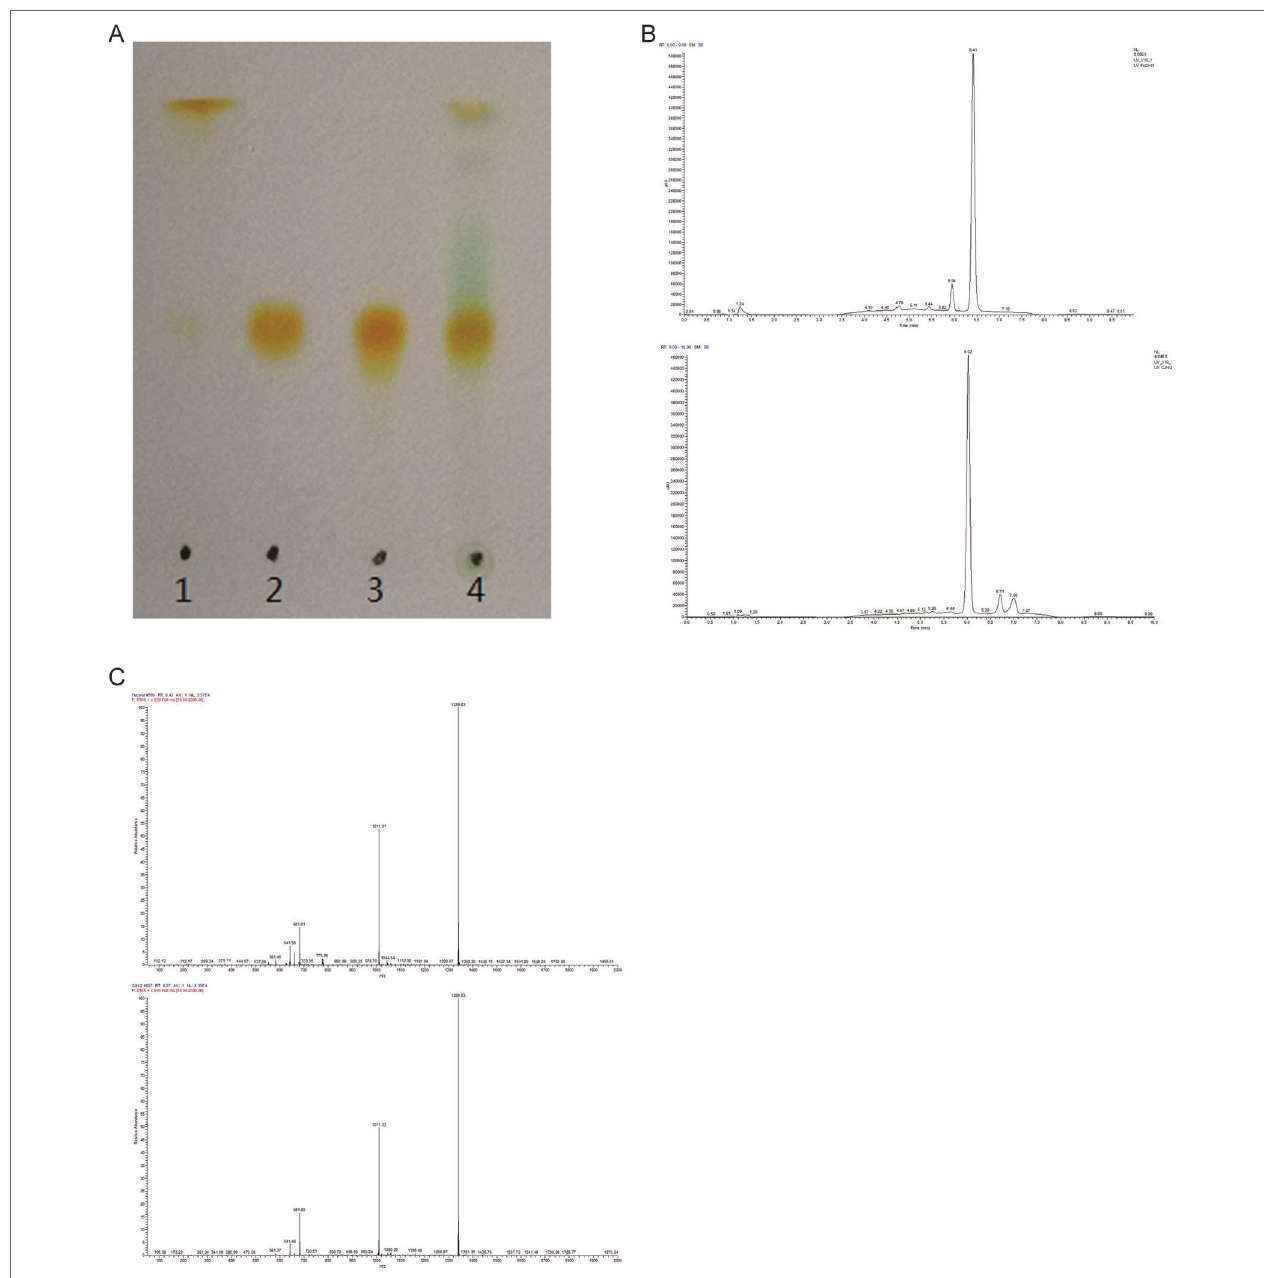
FIGURE 2 | (A) Thin-layer chromatography of standard β -carotene (lane 1), standard fucoxanthin (FX) (lane 2), the purified FX sample of ND-8 (lane 3), and the methanol and acetone extract of ND-8 (lane 4) on a silica plate. (B–C) High-performance liquid chromatogram and mass spectra of standard FX and ND-8 FX eluted by the silica gel column chromatography; the mobile phases used were methanol and deionized water, the mobile phase flow rate was 0.3 ml.min – 1 . Retention times: standard FX, 6.41 min; ND-8 FX, 6.02 min. The diagnostic ions of standard FX are at m / z 641.46 (M + H-HOH) + , 681.81 (M + Na) + , and 1,339.83 (2M + Na) + . The diagnostic ions of ND-8 FX are at m / z 641.46 (M + H-HOH) + , 681.80 (M + Na) + , and 1,339.83 (2M + Na) +